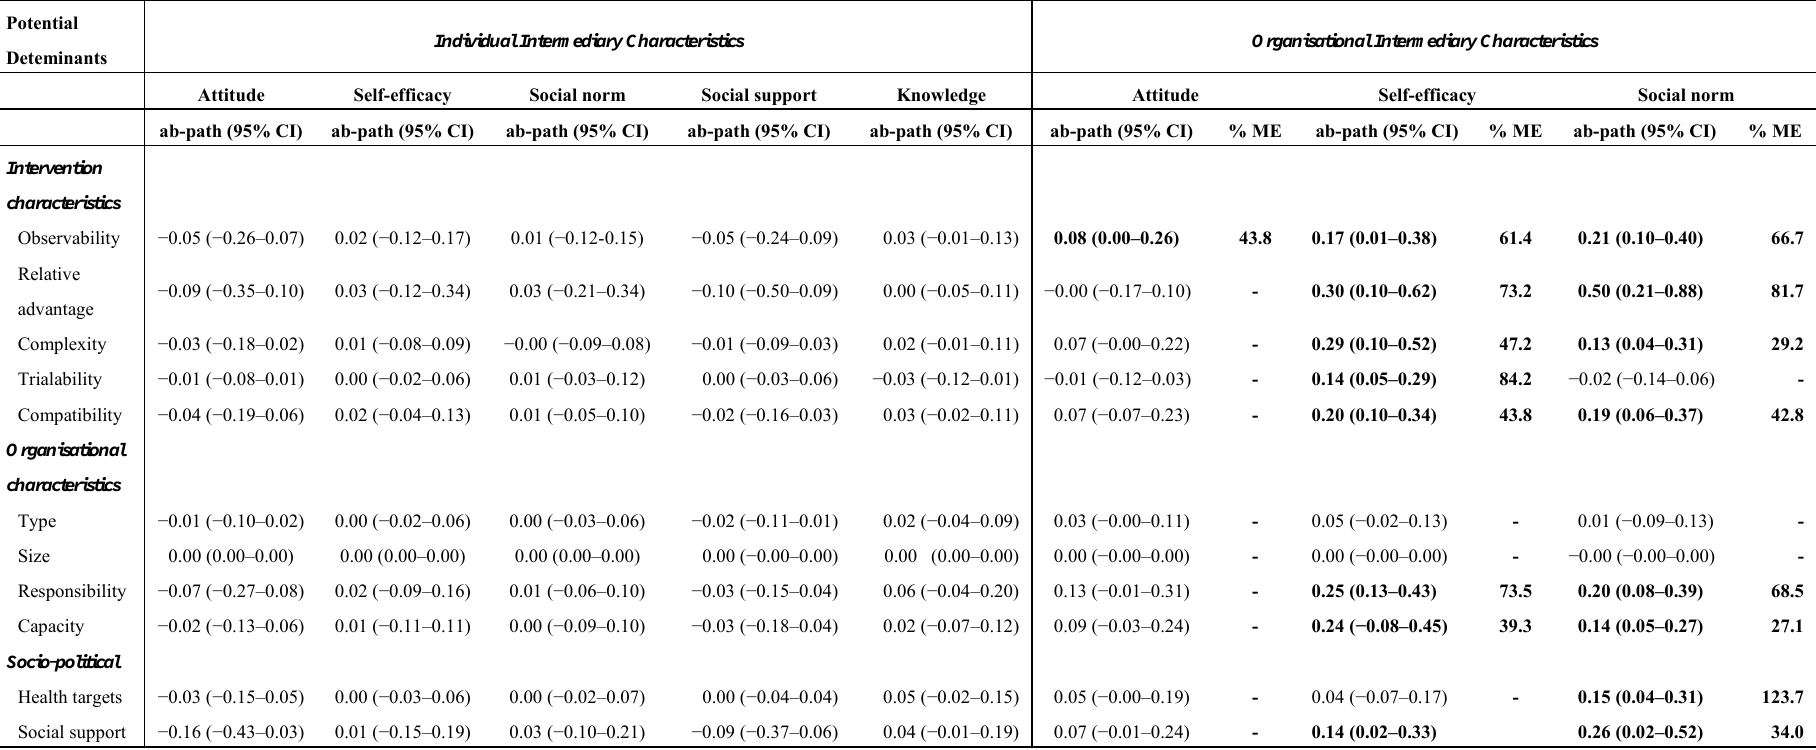
Table 5. Mediating mechanism (ME) of intermediary characteristics on the intention to implement the